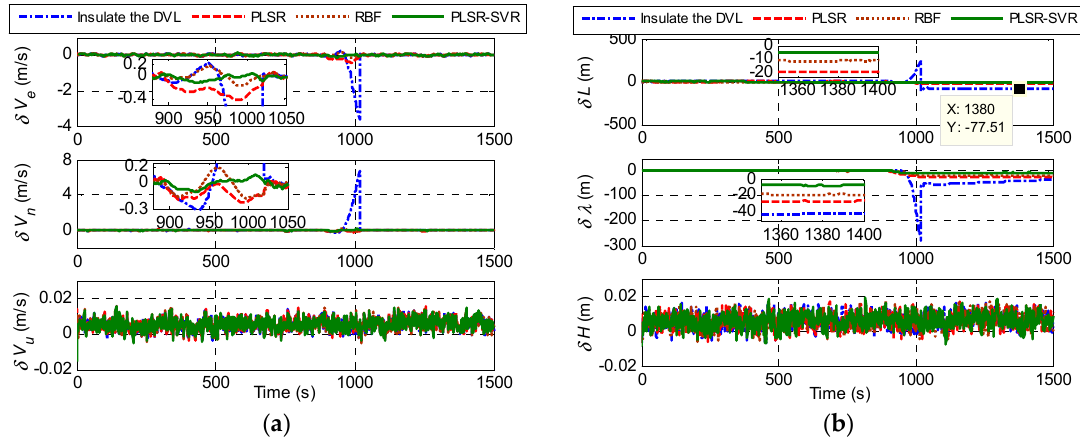
Figure 9. Navigation errors when there is a DVL malfunction for a length of 120s: ( a ) Velocity errors; ( b ) Position errors. Table 4. Error statistics of velocity and position during DVL malfunctions.